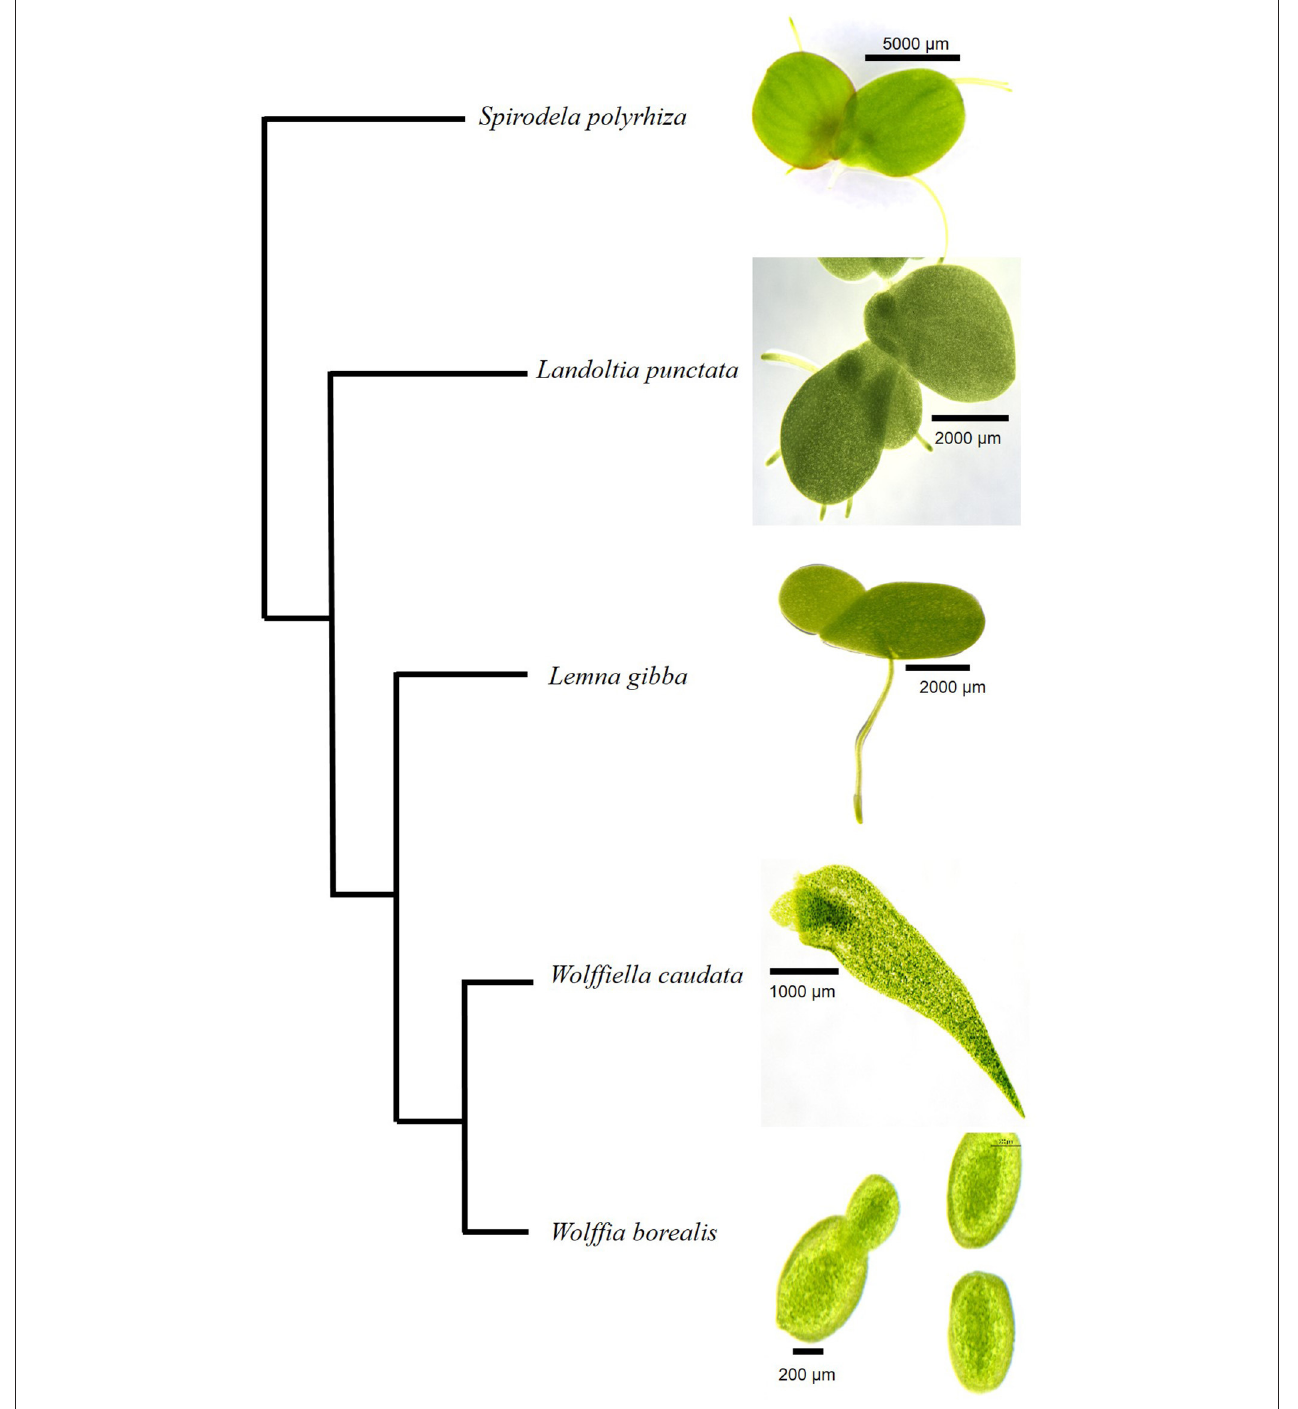
FIGURE 1 | Cladogram of Lemnaceae species analyzed in the present study. The five species from different genera of duckweeds are shown according to the phylogeny suggested by Tippery et al. (2015). A size bar in each photograph indicates the scale as shown for the different specimen.